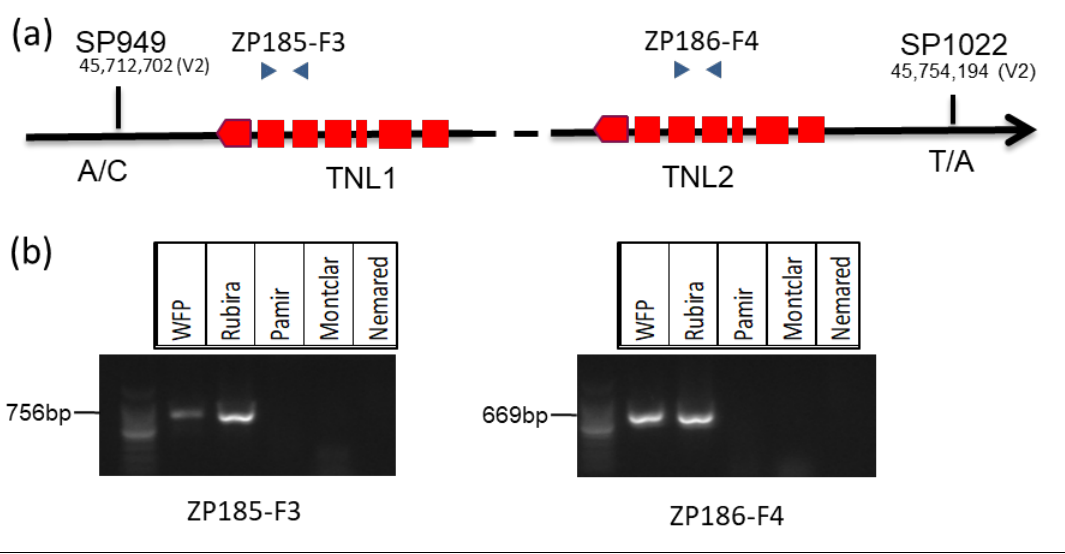
Figure 7. Genotyping for the TNL1 and TNL2 genes of resistant and susceptible peach parents. ( a ) Position of the SNP and specific size markers ( b ) genotyping with the size markers ZP185-F3 and ZP186-F4; the presence of amplicon for resistant and absence of amplicon for susceptible genotypes. We also developed Kasp markers with SNPs flanking the two genes TNL1 and TNL2